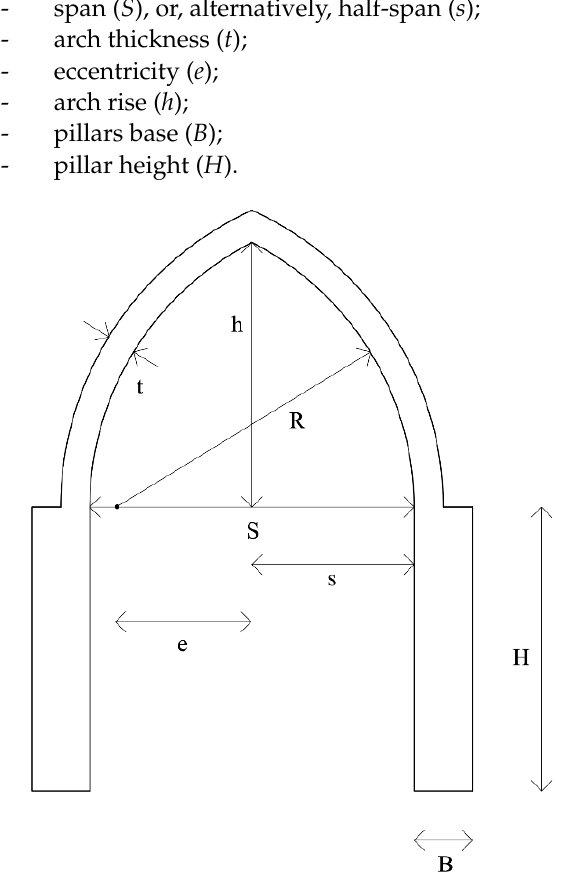
Figure 5. Dimensional parameters for the characterisation of the buttressed arches.